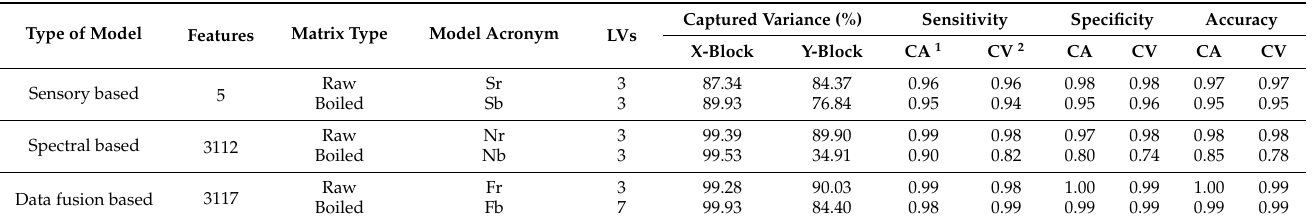
Table 4. Summary of performance metrics for classification models that gave the best results for each computational approach (i.e., sensory-based, spectral-based, and data-fusion-based). Type of